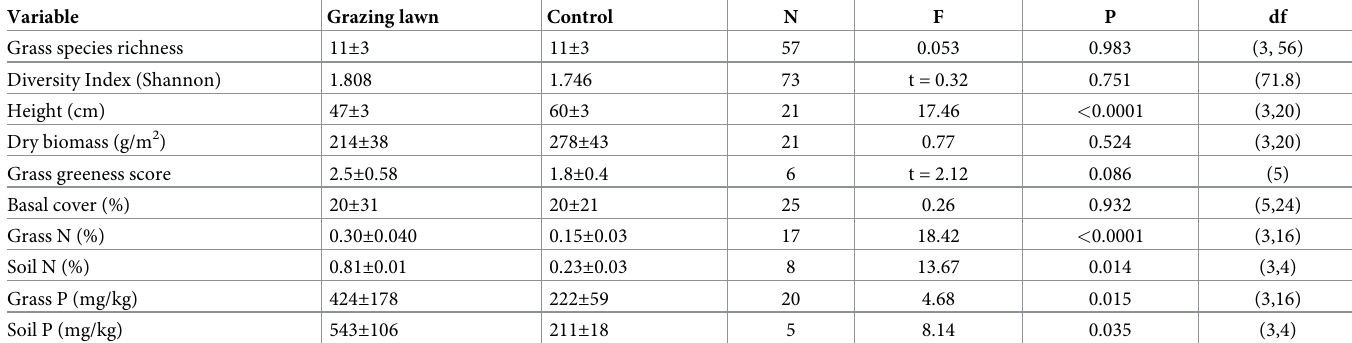
Table 4. Summary of variables assessed on grazing lawn sites vs control sites with their respective sample size (N), F value, t value, P value and degree of freedom (df) values. Data were collected from May 2016 to October 2017 in the Issa Valley, Tanzania. Grass height, biomass, cover, N and P values are shown as mean ± SD. N = sample size for the different analyses.